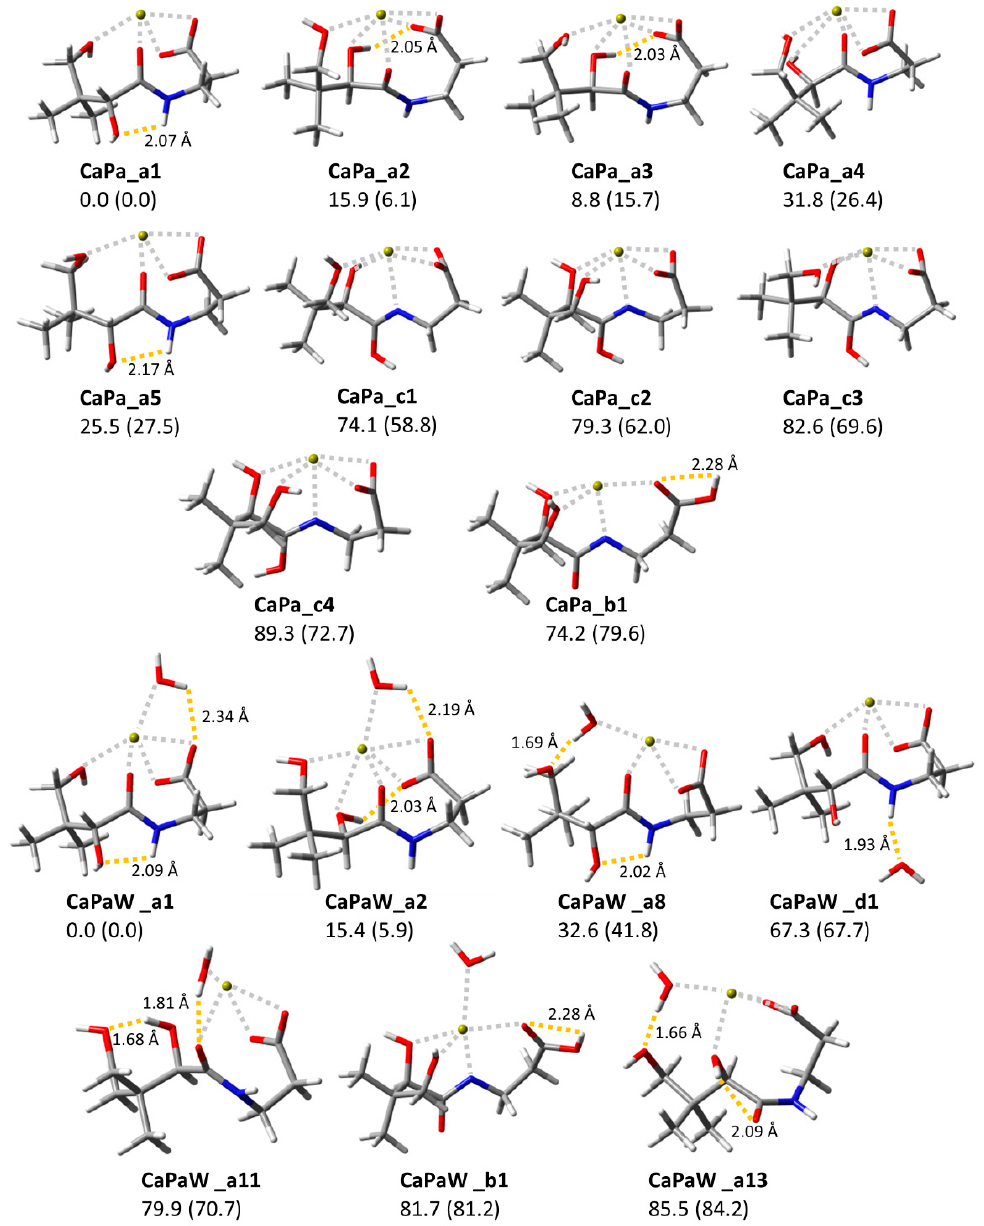
Figure 4. Structures of [Ca(panto-H)] + and [Ca(panto-H)(H 2 O)] + optimized at the B3LYP/6-311++G(d,p) level. Hydrogen bonds are reported with yellow dashed lines together with their length, while gray dashed lines indicate metal bonds. Relative free energies at 298 K in kJ mol − 1 are computed at the B3LYP and MP2 level (in parentheses).